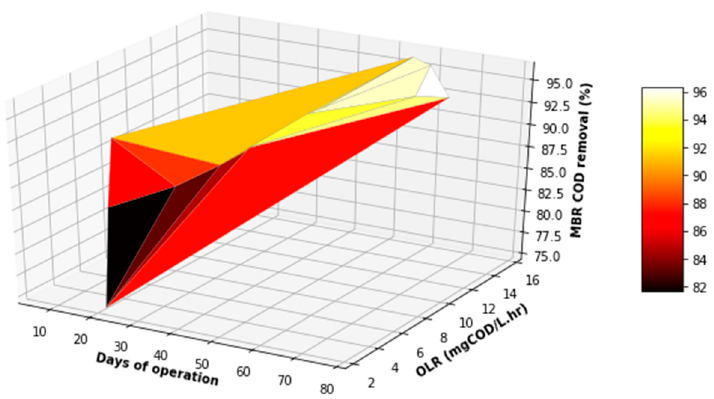
Figure 16. Variation in FOG removal with varying OLR during the operation of the MBR.